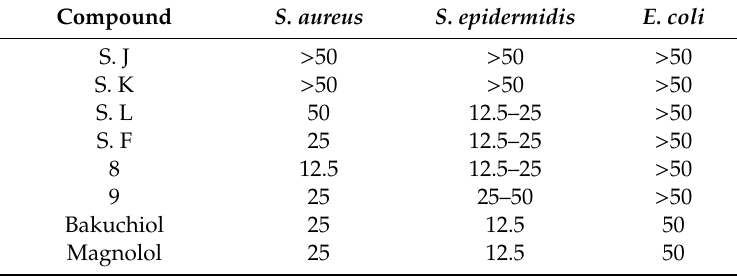
Bakuchiol Magnolol Bakuchiol and Magnolol were used as positive control